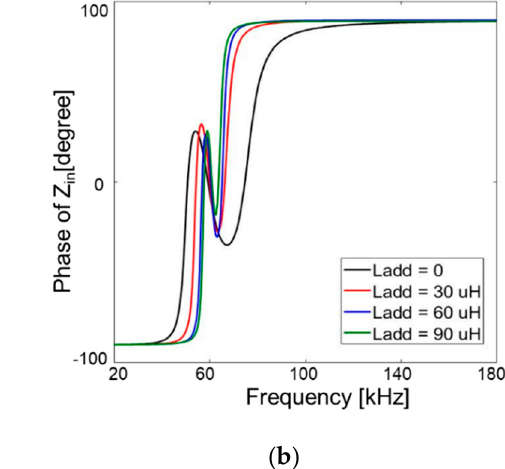
Figure 23. Measured input impedance change according to the series inductance value (L add-tx , L add-rx ): ( a ) input impedance magnitude change according to frequency change; ( b ) input impedance phase change according to frequency change.